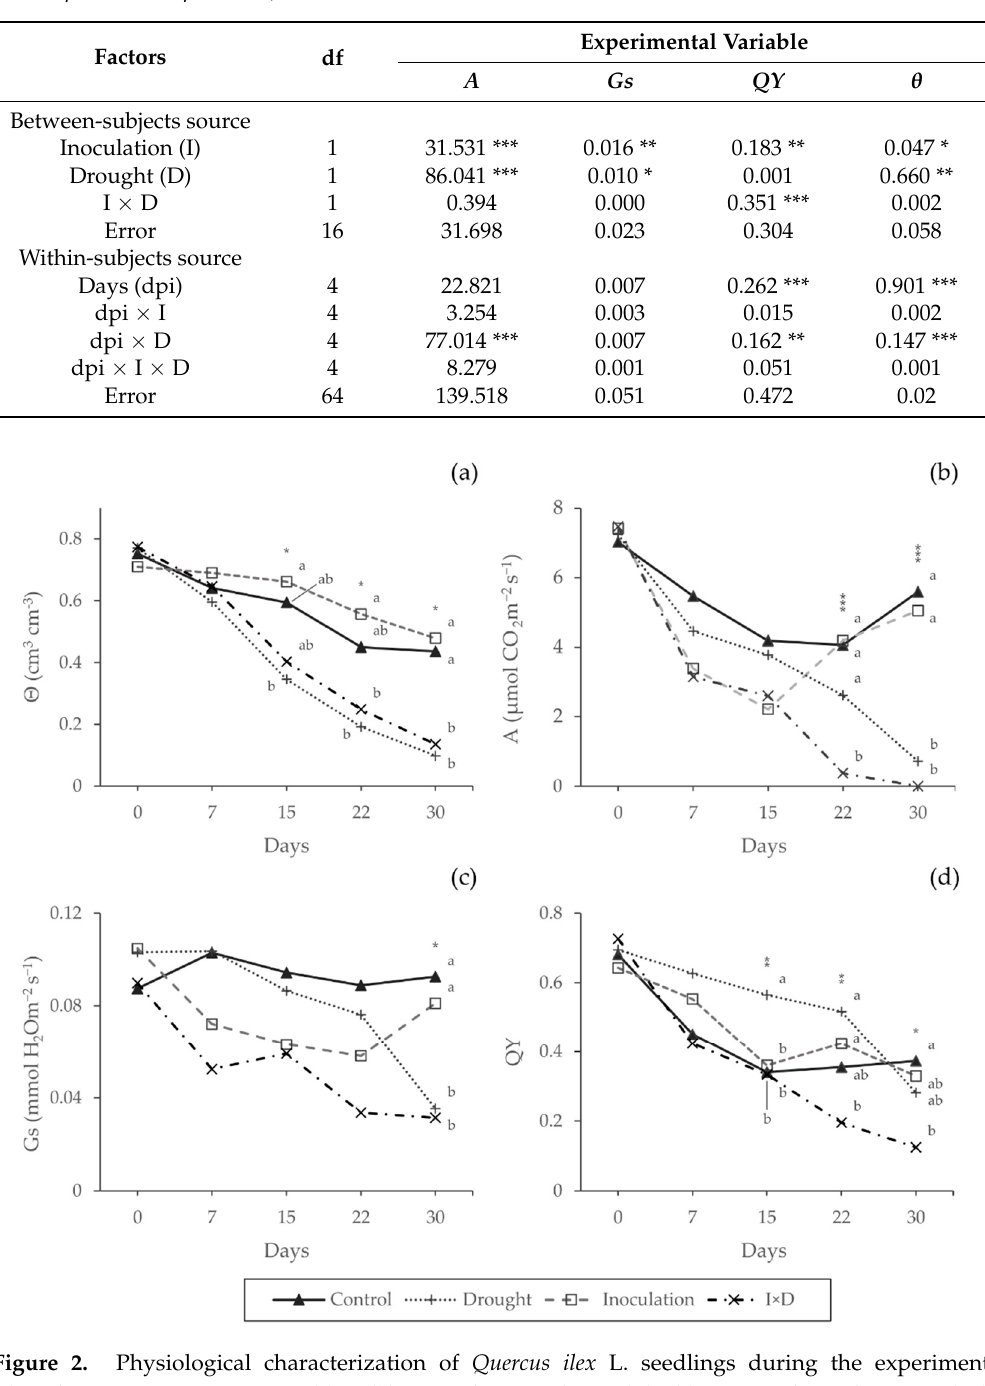
Table 2. Repeated-measures ANOVA (RMANOVA) results for the effect of inoculation and water stress on physiological variables and volumetric water content. The degrees of freedom (df), type III sum of squares are shown for each variable. Geisser-Greenhouse adjusted probabilities were used for the within-subject analysis. Values of sum of squares are highlighted in bold type when significant (* p <